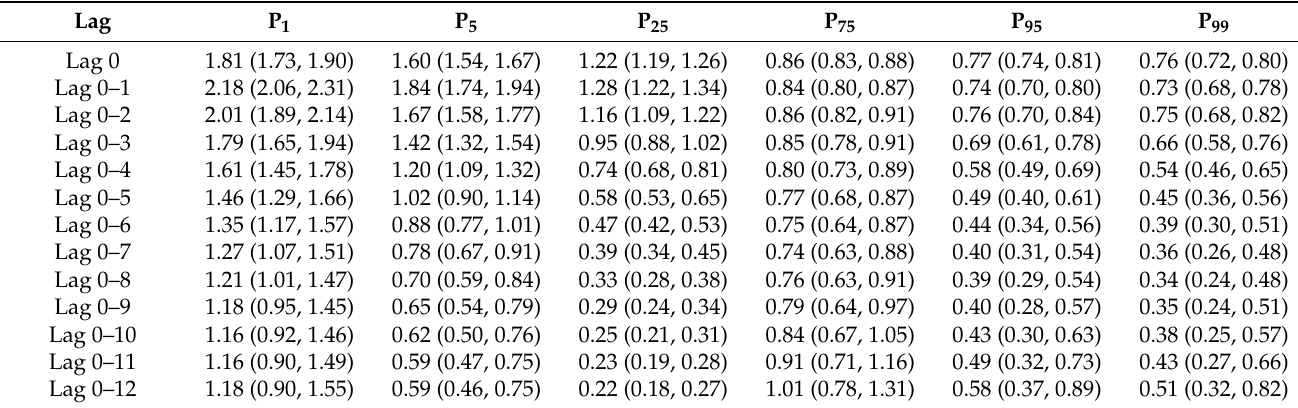
Table 2. The cumulative effects of low and high AT on the incidence of PTB by different lag period in Xinjiang from 2004 to